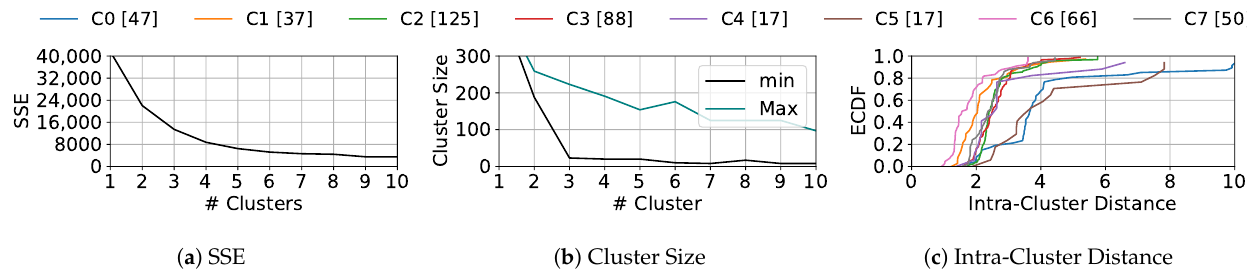
Figure 14. Cluster Metrics wp Working Station 2 Clamp 1, Whole Time-Series Data Selection.